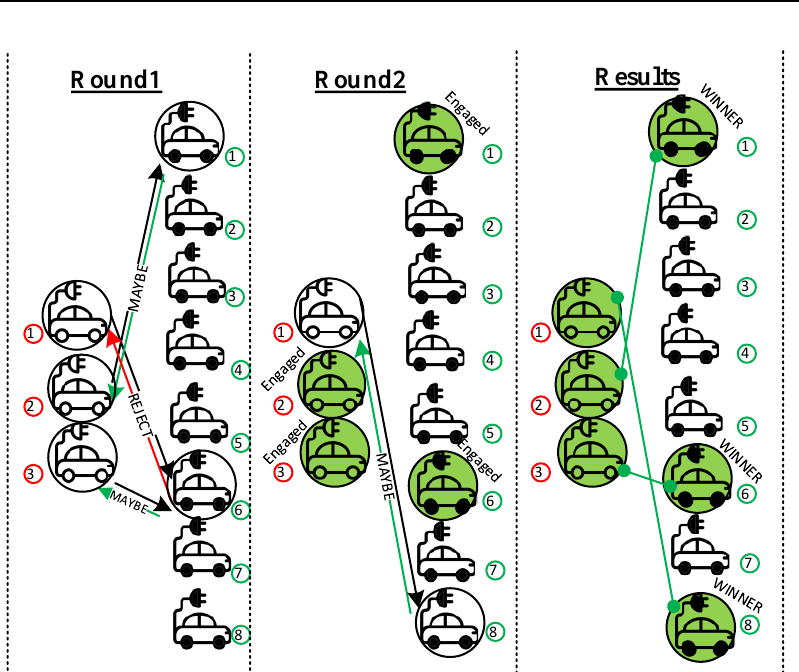
Figure 4. Matching steps in the proposed simulation system.